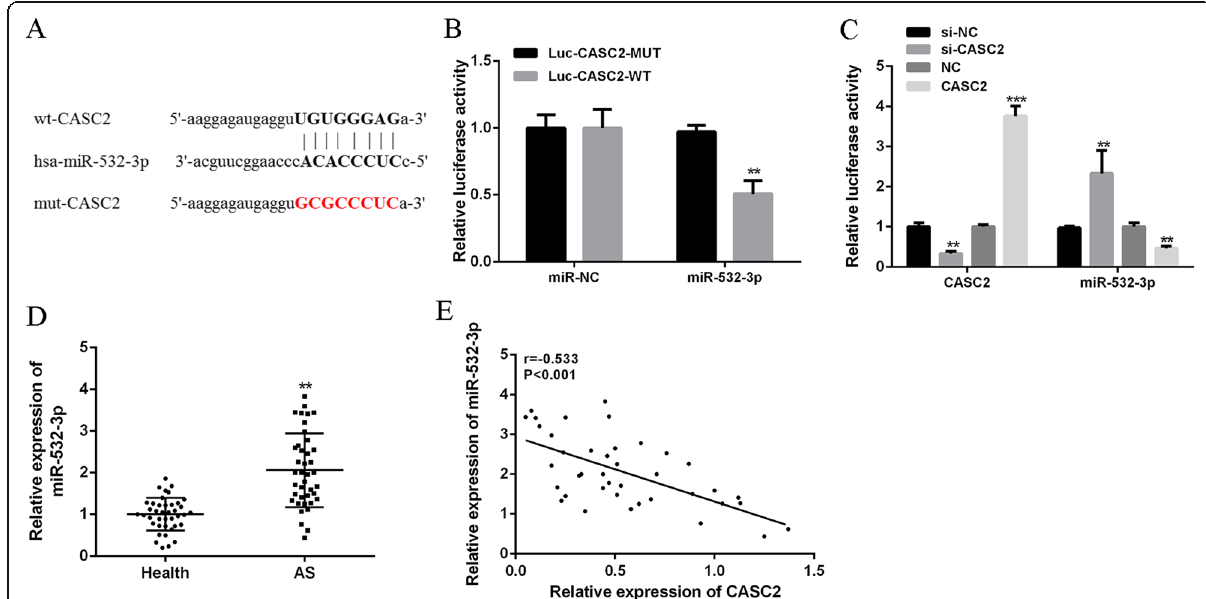
Fig. 2 CASC2 sponged miR-532-3p in AS patients. a The common binding sequences between CASC2 and miR-532-3p by Starbase and RegRNA or PITA database. b The luciferase activities in VSMCs co-transfected with miR-532-3p mimic and CASC2-WT or CASC2-MUT vector. c qRT-PCR for miR-532-3p expression in VSMCs with si-CASC2 or CASC2. d qRT-PCR for miR-532-3p expression in serum of AS patients and healthy people. e Pearson ’ s correlation between CASC2 and miR-532-3p in the serum of AS patients ( r = − 0.533, P < 0.001). ** P < 0.01; *** P < 0.001